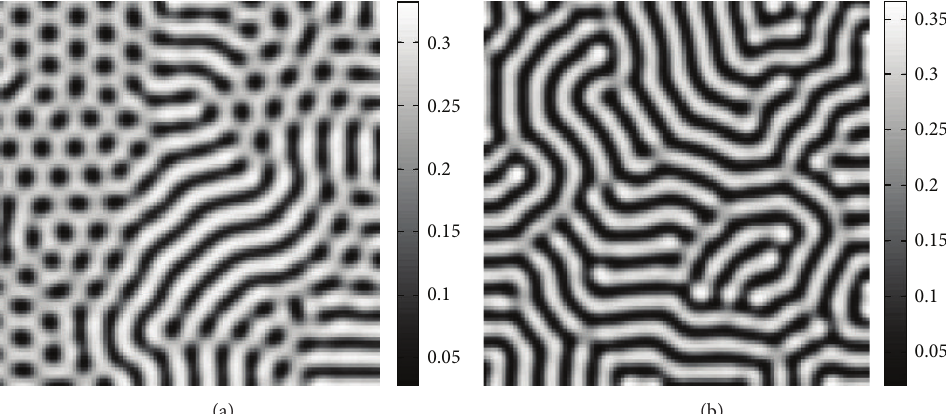
Figure 3: Pattern formation of the prey 𝑢 of model (3) with 𝑞 1 = 0.6 , 𝑐 1 = 1.87 (a) and 𝑐 1 = 1.95 (b). Iterations: (a) 100000 and (b) 20000 .